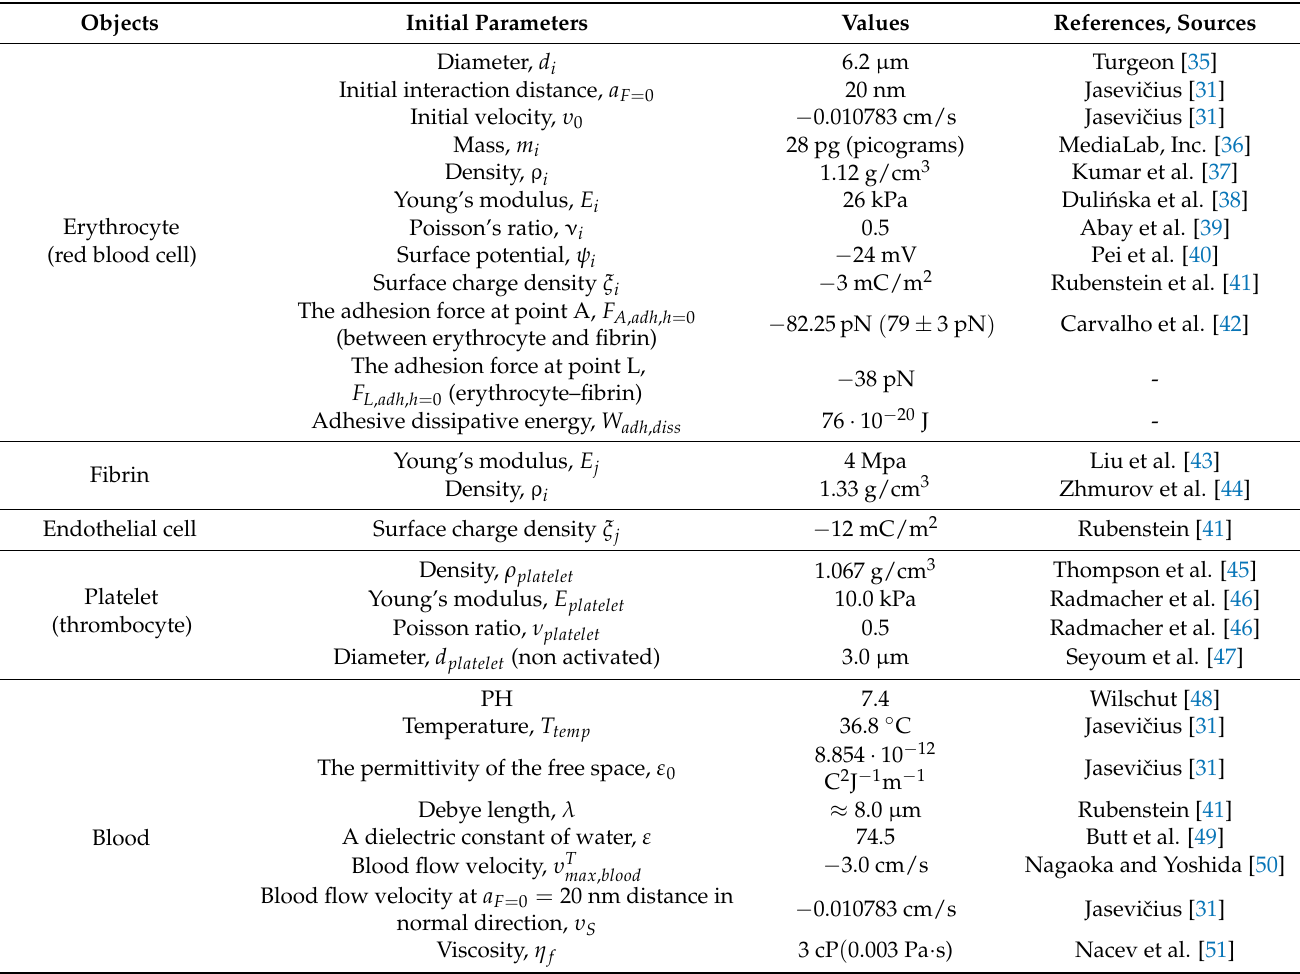
Table 1. Initial